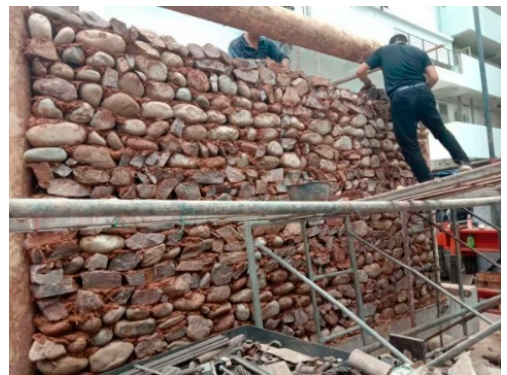
Figure 5. The masonry construction of the mud and stone infill wall.